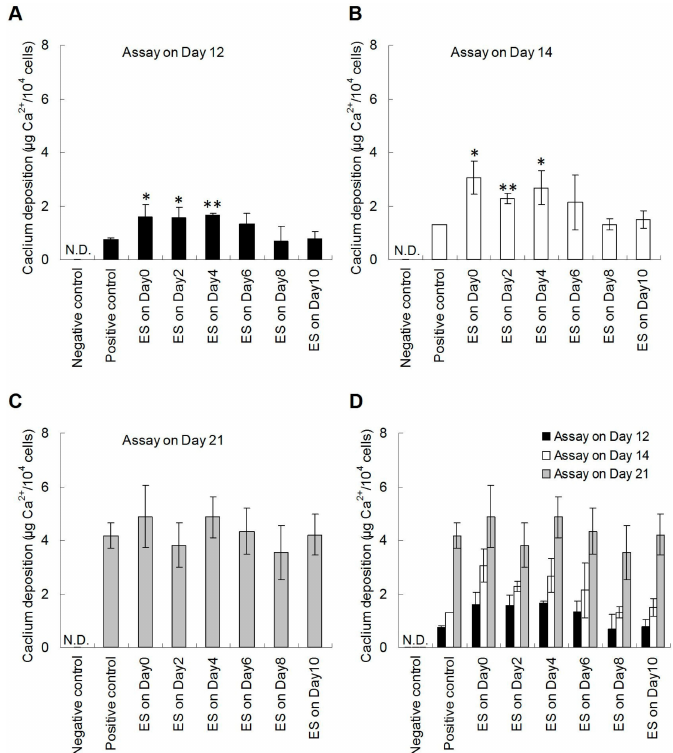
Figure 6. The normalized quantification of calcium deposition of hDPSCs under DCEF treatment at di ff erent stages of osteo-di ff erentiation. To distinguish whether the calcium deposition results were a ff ected by cell proliferation, the quantification results in Figure 5 were divided by cell numbers for normalization. Cells were lysed and the released LDH were evaluated to determine cell numbers. The normalized results were evaluated on ( A ) day 12, ( B ) day 14, and ( C ) day 21 after osteo-induction. ( D ) The results from all experimental groups were grouped to better understand the e ffi cacy of ES. The negative and positive control groups were hDPSCs cultured on PPy films using normal or osteogenic media, respectively. These two control groups were not treated by DCEF. ( n = 3; *: p < 0.05, **: p < 0.01 compared with the positive control group) (N.D.: